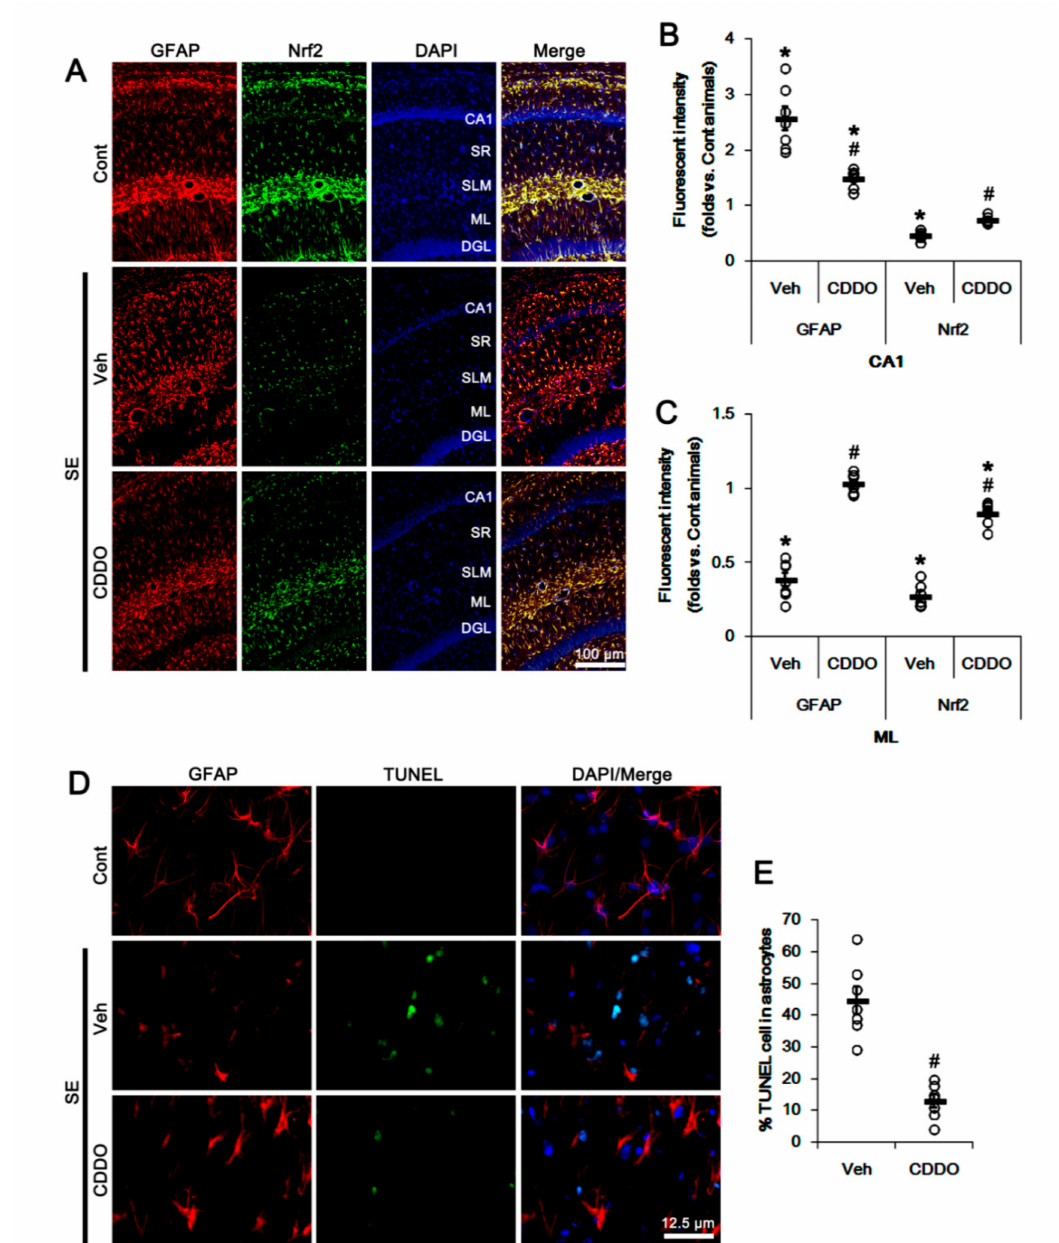
Figure 2. E ff ects of CDDO-Me on Nrf2 expression and astroglial responses following SE. CDDO-Me ameliorates the reduced Nrf2 expression in CA1 astrocytes and ML astrocytes following SE. CDDO-Me also attenuates reactive CA1 astrogliosis and ML astroglial apoptosis induced by SE. ( A ) Representative photos of GFAP and Nrf2 in the hippocampus. Abbreviations: CA1, CA1 pyramidal cell layer; SR, stratum radiatum; SLM, stratum lacunosum-moleculare; ML, molecular layer of the dentate gyrus; DGL, dentate granule cell layer. ( B , C ) Quantification of the fluorescent intensities of GFAP and Nrf2 in CA1 ( B ) and molecular layer regions ( C ). Open circles indicate each individual value. Horizontal bars indicate mean value. Vertical bars indicate S.E.M. (*,# p < 0.05 vs. control animals and vehicle, respectively, one-way ANOVA followed by Newman-Keuls post hoc test; n = 7, respectively). ( D ) Representative photos of apoptosis of ML astrocytes. ( E ) Quantification of the fraction of TUNEL-signals in ML astrocytes. Open circles indicate each individual value. Horizontal bars indicate mean value. Vertical bars indicate S.E.M. (# p < 0.05 vs. vehicle, two-tailed Student t -test; n = 7,